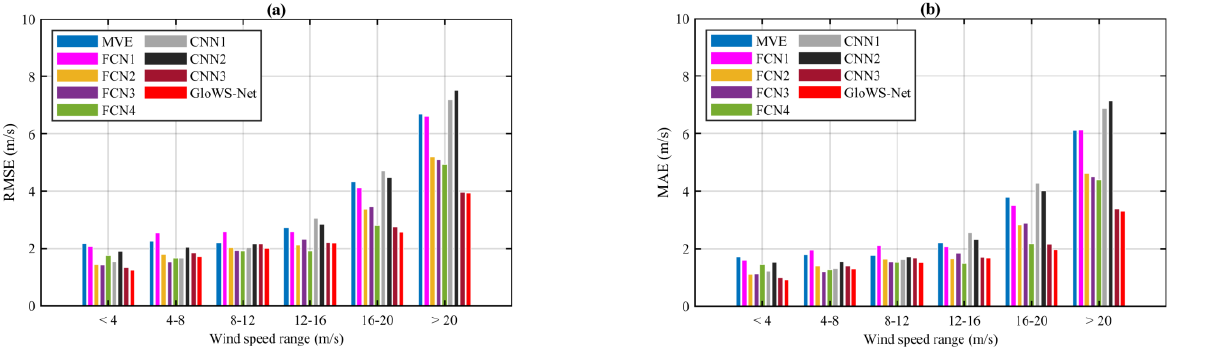
Figure 6. When ERA5 wind speed is used as reference for ( a ) RMSE and ( b ) MAE for different wind speed ranges.